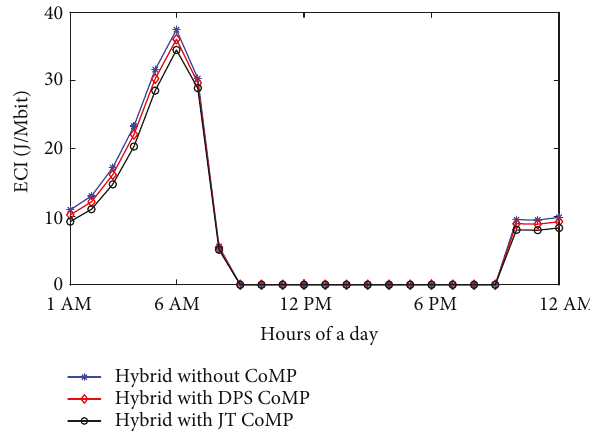
Figure 8: ECI comparison among the di ff erent hybrid models without